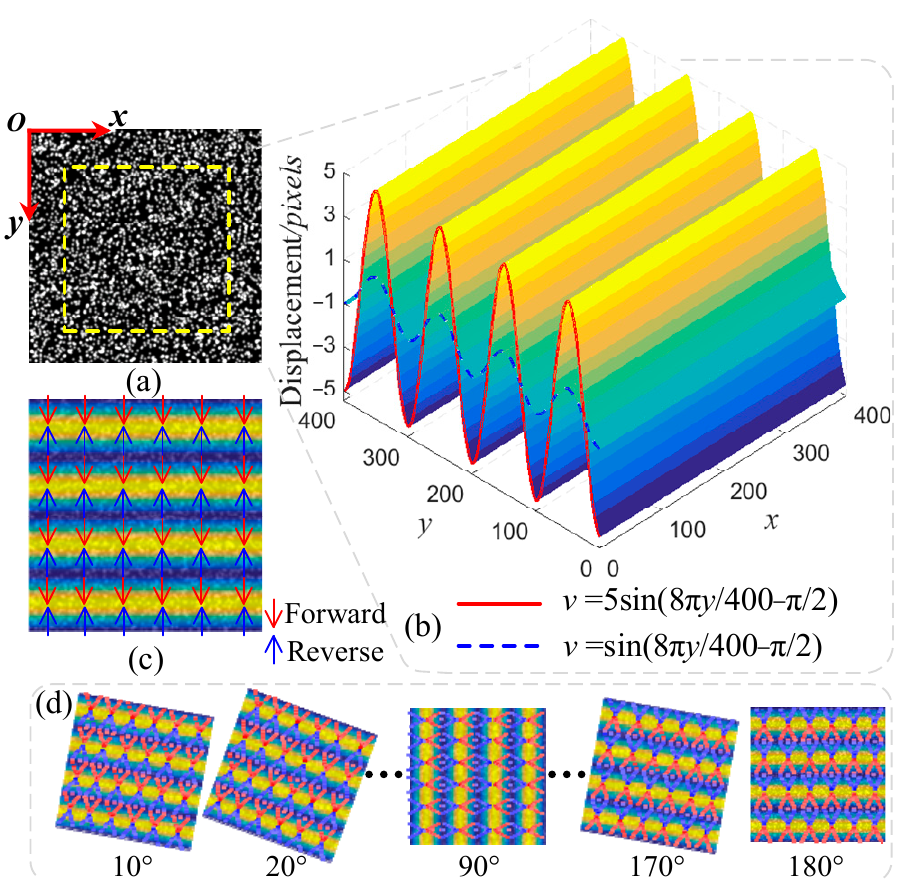
Figure 2. Theoretical deformation field along the y -direction mapped onto numerical images: ( a ) Reference image; ( b ) Simulated sinusoidal displacement field in y-direction; ( c ) Deformation image; ( d ) a series of deformed images with increasing rotation angles.